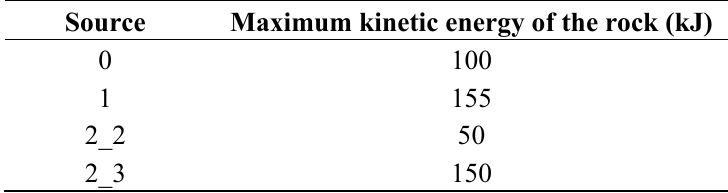
Figure A1. The map of rock source areas (coloured light blue), source points (coloured dark blue) and the maximal rockfall reach on the main road produced with the shadow angle method (red colour). Red lines represent borders of roughness polygons. Table A1. Rockfor.NET results for sources that endanger the regional or forestry